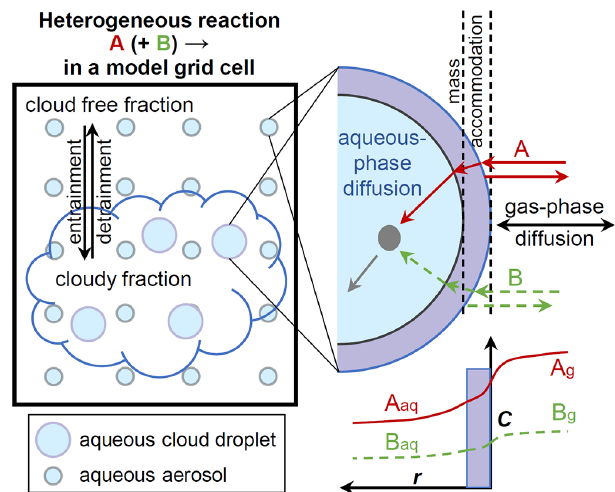
Figure 1. Schematic of physicochemical processes that control the heterogeneous reaction of a molecule A (with another molecule B) in a model grid cell. (Left). Entrainment and detrainment of air into and out from clouds. The volume occupied by aqueous clouds in the grid cell is represented by the cloud fraction ( f c ), which is pro- vided by the MERRA-2 meteorological reanalysis in this study. The cloud-free fraction is thus 1 − f c . Aqueous aerosols are assumed to be evenly distributed in the grid cell. For aqueous cloud droplets and aqueous aerosols, the same mass transport processes are con- sidered and are shown in the right panel. (Top Right). Gas-phase, interfacial, and aqueous-phase mass transport limitations for the molecules A and B. (Bottom Right). Concentration ( C ) profiles of A and B are a function of radial distance ( r ) from the surface of a spherical particle. The subscripts g and aq refer to gas and aqueous phases, respectively. The concentrations are in arbitrary units and their scales are different for gas and aqueous phases. The entrain- ment/detrainment processes for clouds have been described in detail by Holmes et al. (2019). The right panel is adapted from Fig. 4 in Ravishankara